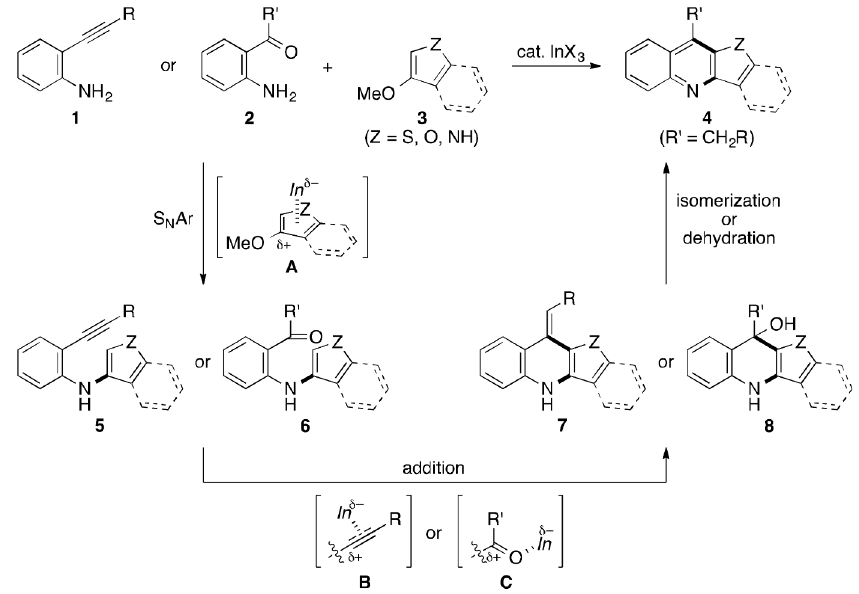
Scheme 1. A working hypothesis for the synthesis of HA[ b ]Qs 4 . In = InX 3